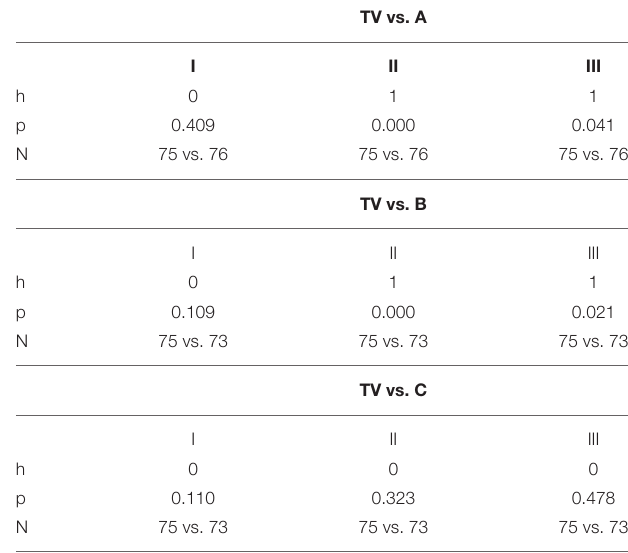
TABLE 3 | Capsaicin pain: comparisons of normalized mean SCL in treatments A, B, and C vs. the training visit, TV, within each of regions I, II,